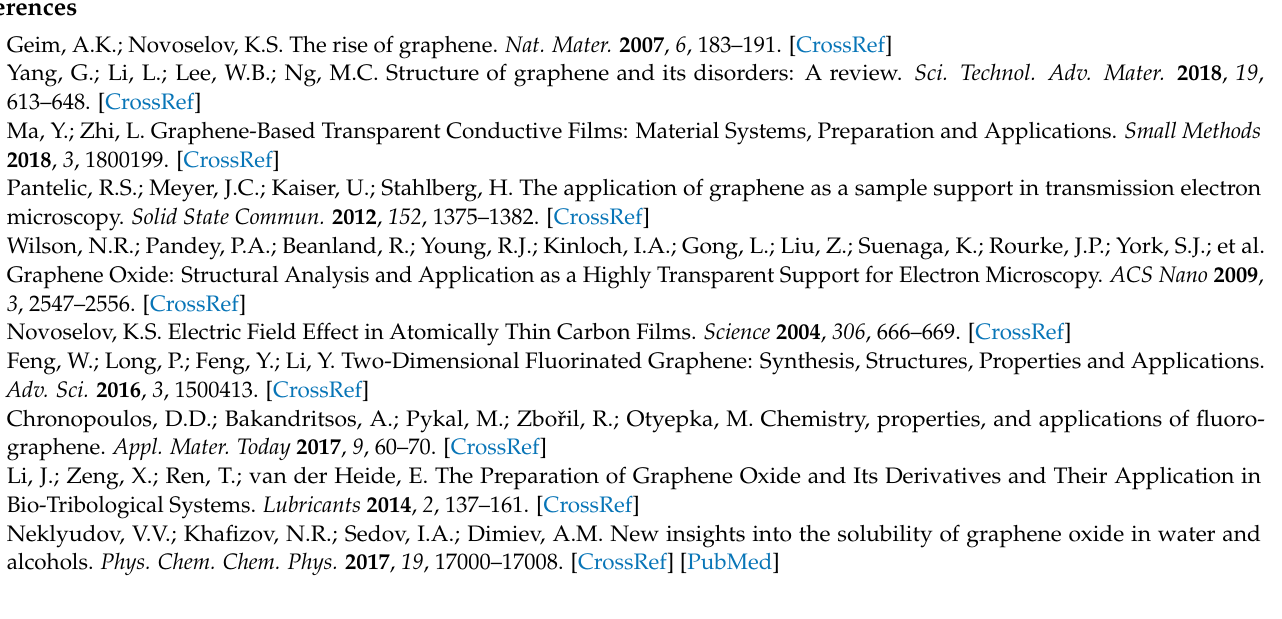
grid. Figure S3: Water treated GO is distributed as discontinuous, small, monolayered flakes and multi-layered and aggregates. Figure S4: Cryo-EM imaging of different biological samples on GO monolayer. Figure S5: Cryo-EM structure determination of E. coli 70S Ribosome vitrified on GO monolayer coated grid. Figure S6: Transmission Electron Microscopic analysis of GO isopropanol- water and GO ethanol-water